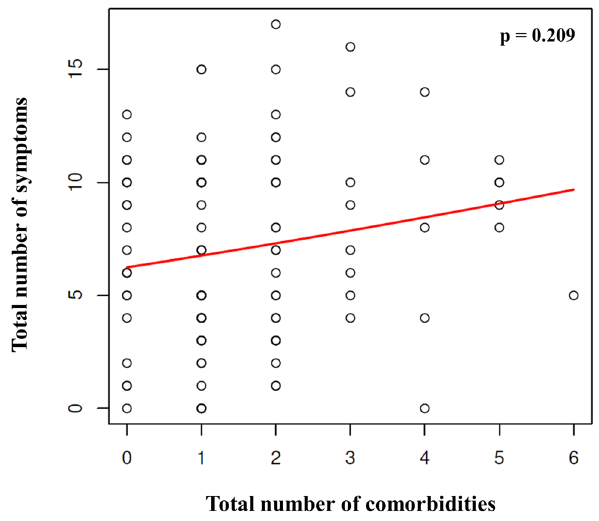
Figure 5. The relationship between comorbidities and the number of symptoms in outpatients. Figure represents the relationship between the total number of comorbidities and the total number of symptoms in outpatients (Spearman’s rank correlation r = 0.12, p = 0.21). One circle corresponds to a unique patient, however, the circles of some patients may overlap in the graph. The red line represents a non-parametric regression function.